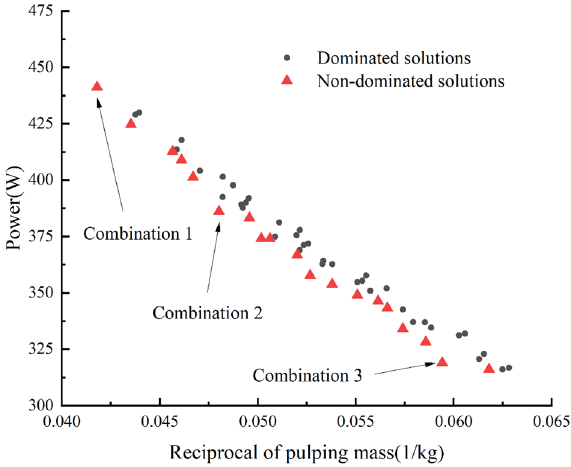
Figure 6. P 2 -1/M 2